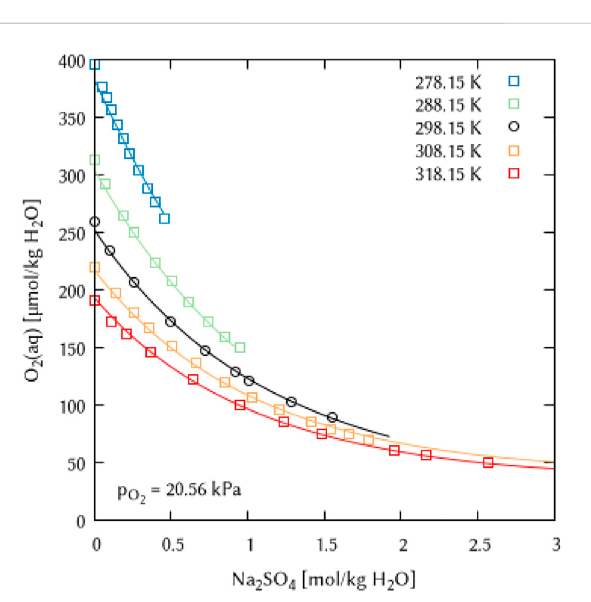
FIGURE 13 Modelling of the O 2 solubility in potassium hydroxide solution as a function of temperature and KOH concentration. (Points: Experimental data from □ Geffcken (1904), ○ Davis et al. (1967), n Gubbins and Walker (1965), ▽ Shooret al. (1968) and ⬦ Langand Zander (1986), Lines: this work).